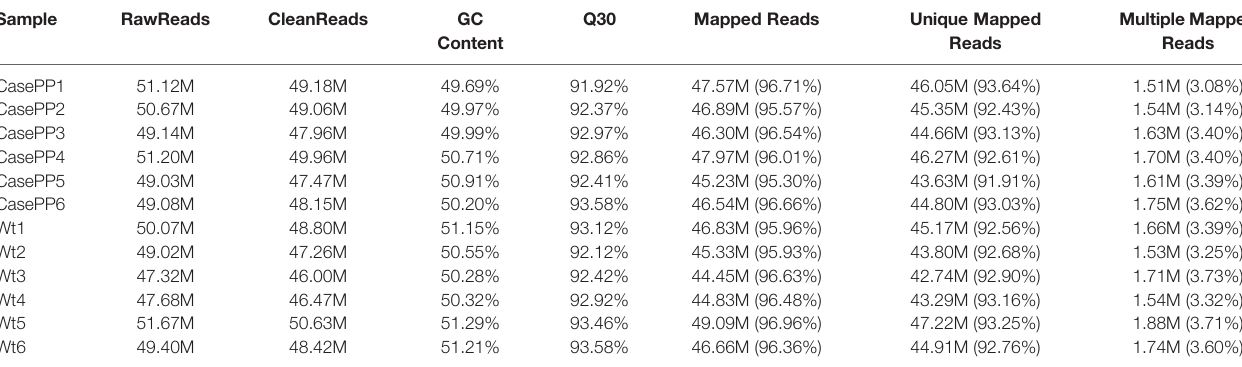
TABLE 1 | Statistics for the sequenced transcriptomic